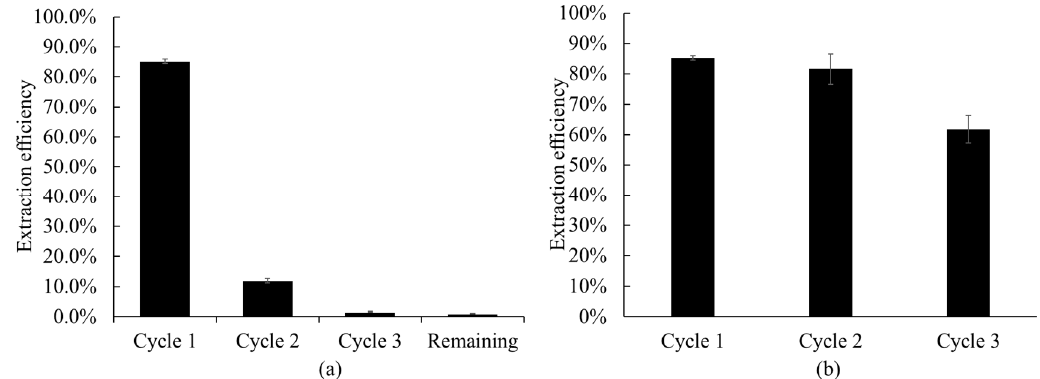
Figure 3. Sulfolane removal using a three-cycle soil washing; ( a ) the percentage sulfolane removal for each cycle and ( b ) the extraction efficiency for each cycle. The error bars represent the variation of duplicates.